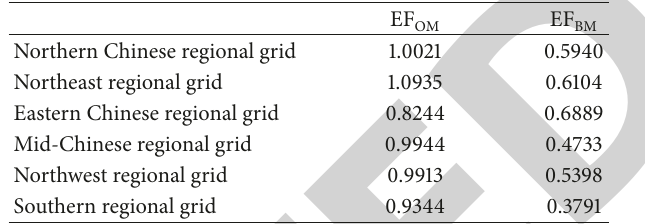
Table 4: 2012 baseline emission factors for regional power grids in 2 China (tCO 2 /